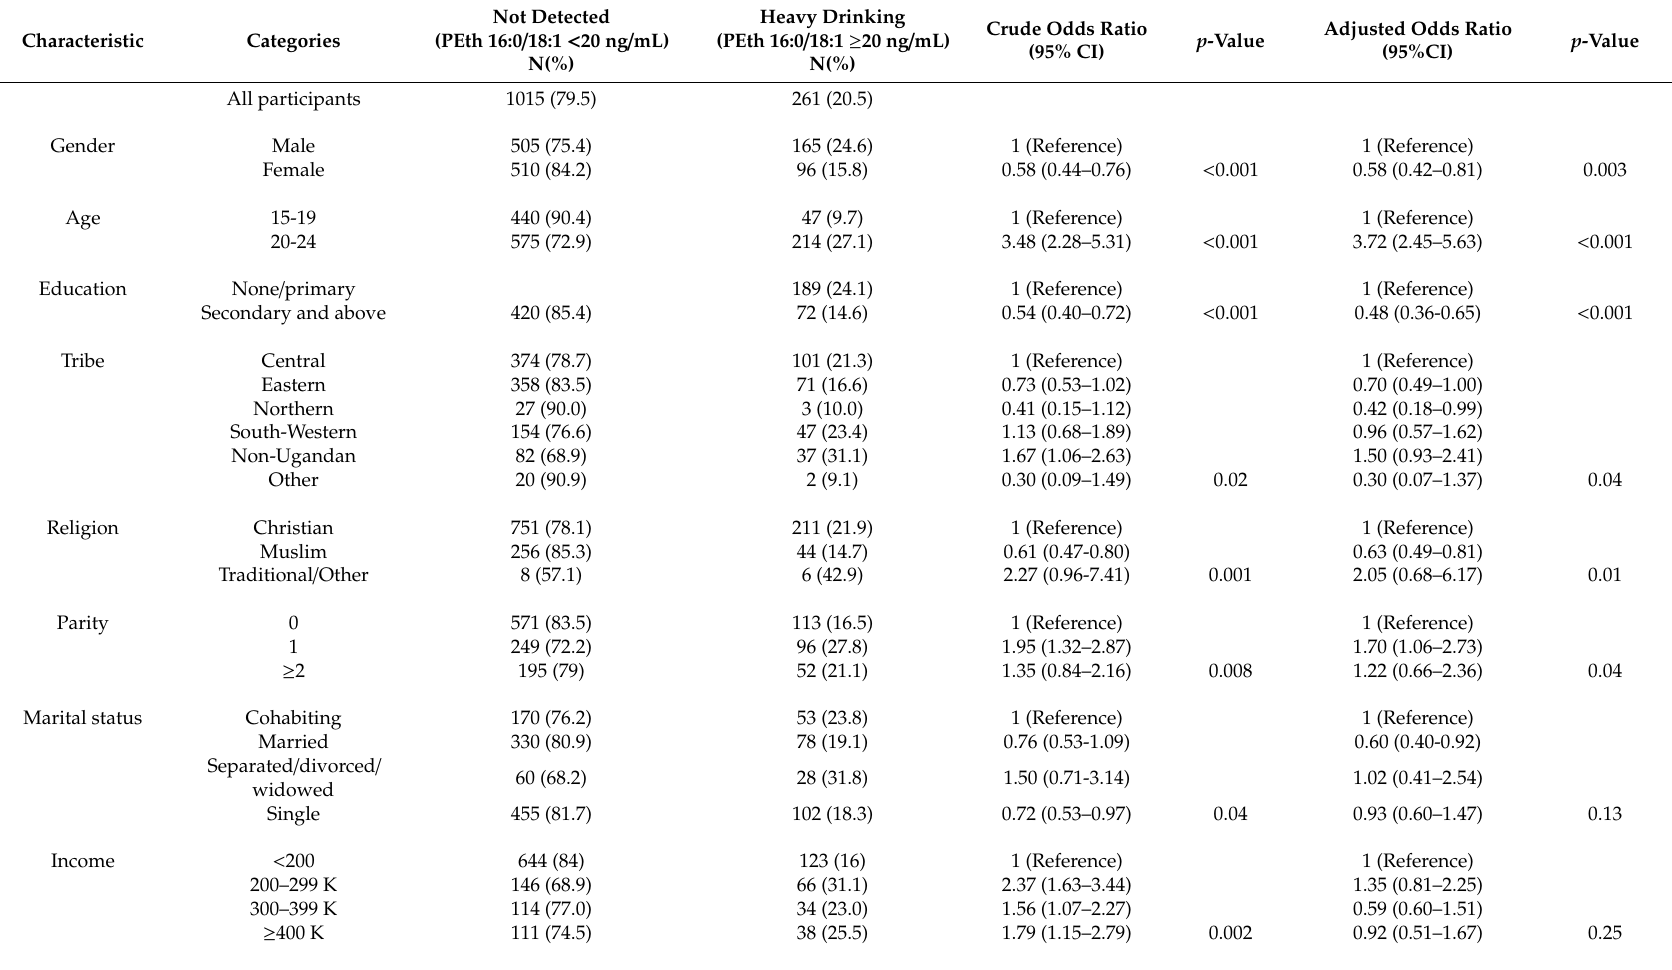
Table 3. Risk factors for alcohol misuse (PEth 16:0 / 18:1 ≥ 20 ng / mL) among young people aged 15–24 years in fishing communities in